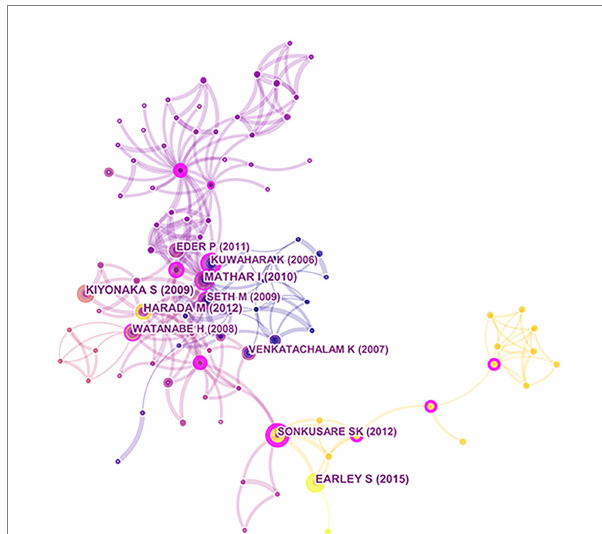
FIGURE 11 Co-citation analysis of references. Using VOSviewer, depict a co- citation analysis of references from 2010 to 2020. In VOSviewer, the size of a circle indicates number of citations. The purple area of the circle indicates the centrality of a